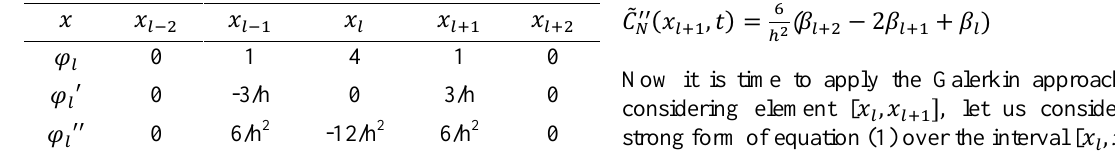
Table 1 . Values of approximate function and its derivatives at the end points of the